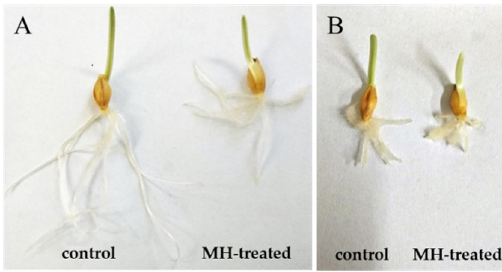
Figure 1. The representative 3-day-old seedlings of barley: cv. “Sebastian” ( A ) and hvatr.g mutant ( B ): control and treated with 4 mM MH. Bar 1 cm.